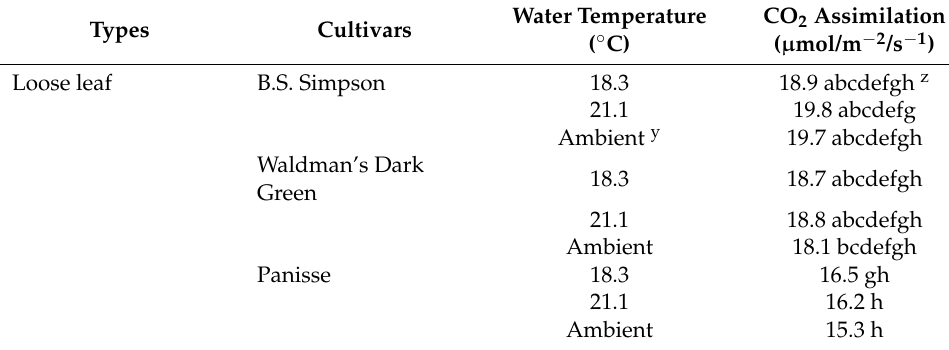
Table 2. Least square means for lettuce cultivar and water temperature (18.3 ◦ C, 21.1 ◦ C, and ambient) for net CO 2 assimilation in NFT hydroponic systems at OSU research greenhouses in Stillwater, OK,